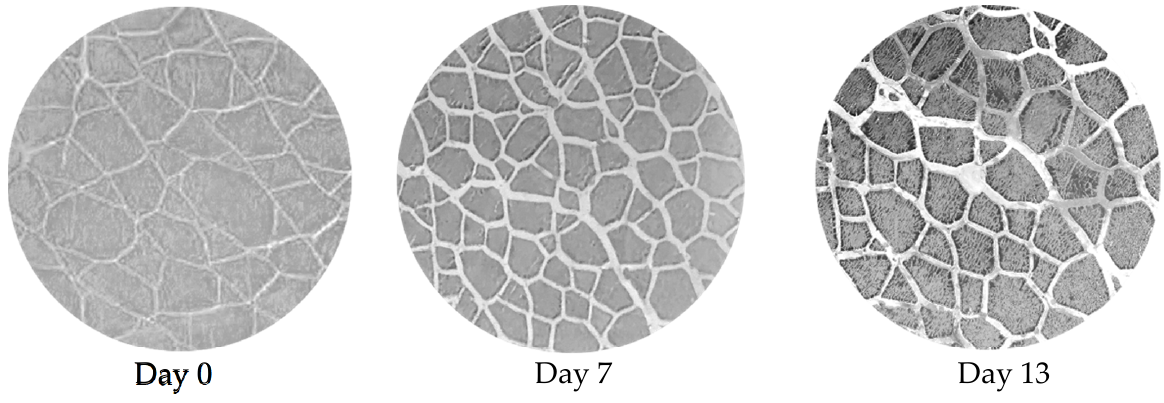
Figure 8. Cross-sections of white muscle fillets stained with H&E. The sections are representative of the fillet structure on harvest day (day 0), and 7- and 13-days post-harvest. The temporal differences in white muscle structure did not differentiate from the harvest method.